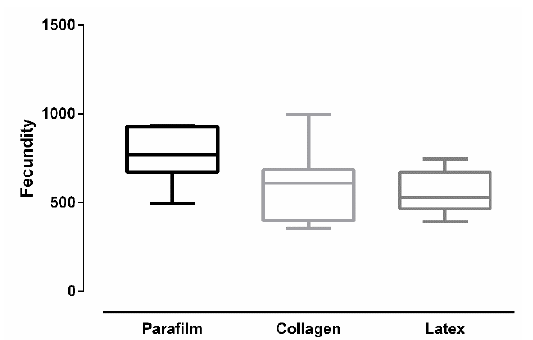
Figure 7. Fecundity of Culex quinquefasciatus females after artificial blood feeding on different membranes (bars = ±SEM).